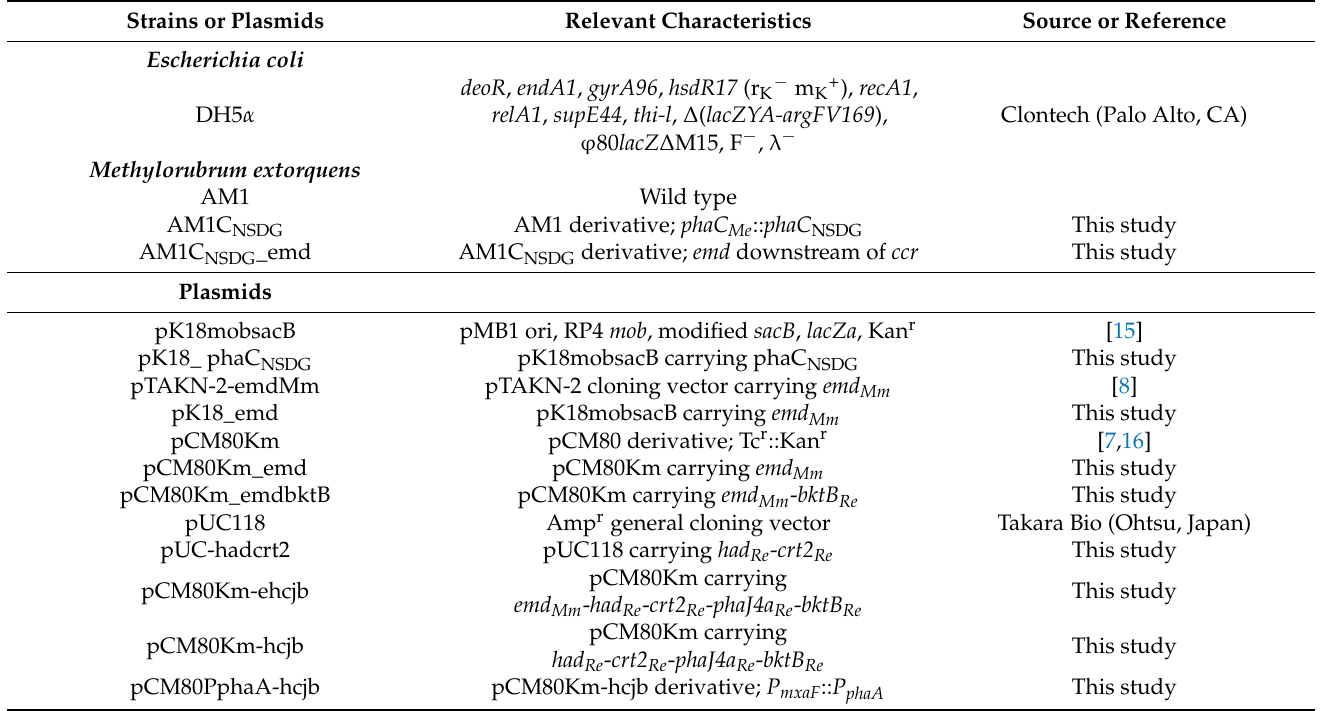
Table 1. Strains and plasmids used in this